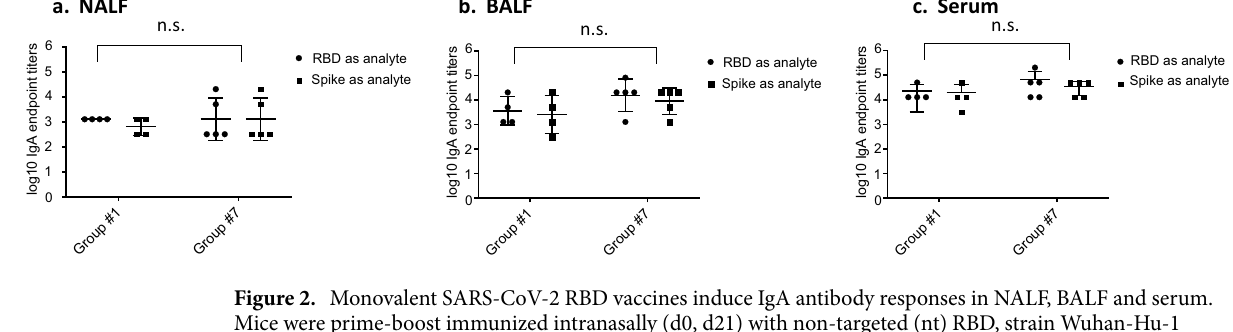
Figure 2. Monovalent SARS-CoV-2 RBD vaccines induce IgA antibody responses in NALF, BALF and serum. Mice were prime-boost immunized intranasally (d0, d21) with non-targeted (nt) RBD, strain Wuhan-Hu-1 (group #1), or M-cell targeted RBD (RBD-cCPE, group #7). Both vaccines were adjuvanted with Riboxxim. Sera were obtained on day 28, 1 week after the boost, diluted in fourfold steps, and assayed for IgG antibodies in Luminex with recombinant nt RBD, or recombinant trimeric spike protein, both derived from SARS-CoV-2 strain Wuhan-Hu-1. Endpoint titers (EP) were defined as highest dilution of a sample exceeding the mean signal of the lowest 2 dilutions + 3SD. Log10 of endpoint titers were plotted with geometric mean ± geometric SD. Two- way comparisons using the Mann–Whitney U test.